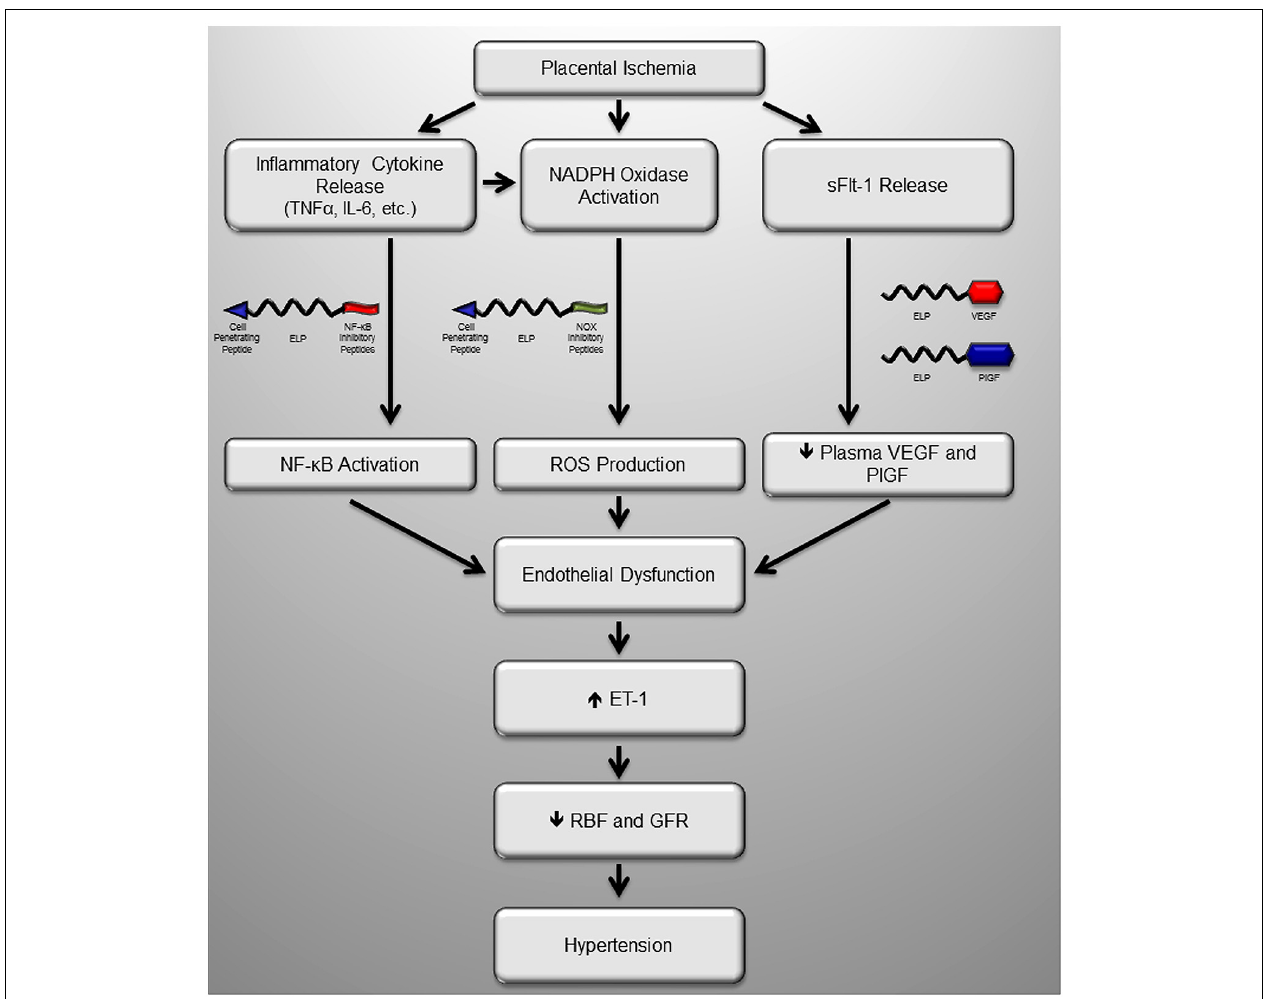
FIGURE 2 | Potential sites of intervention with maternally restricted therapeutic peptides during preeclampsia. We have recently produced several novel maternally restricted peptide therapeutics to target known pathologic molecules produced in response to placental ischemia in preeclampsia. Much of the activity of inflammatory cytokines is through the master regulator NF- κ B, which could be blocked by the inhibitory ELP-p50 peptide which blocks nuclear translocation of NF- κ B, a transcription factor.The major source of oxidative stress in the ischemic placenta is the NADPH